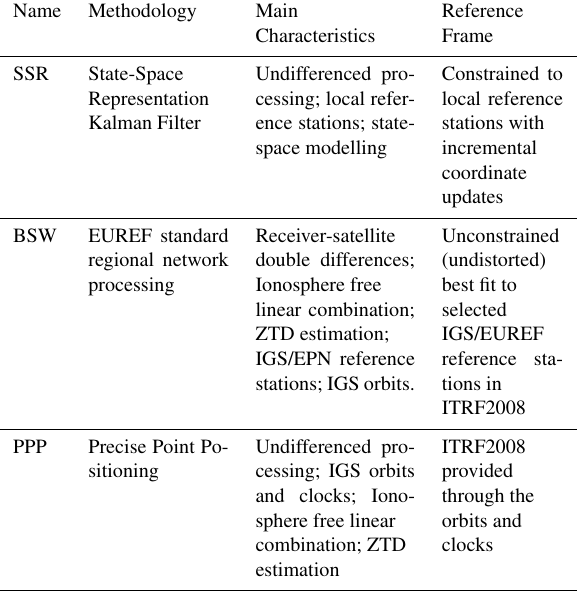
Table 2. GNSS processing methodologies. SSR processing has been carried out by 06-GPS using Geo ++ software (Wübbena et al., 2001); BSW by the Dutch Cadastre using the Bernese GNSS software (Dach et al., 2015); PPP by Nevada Geodetic Laboratory (NGL) using Gipsy/Oasis software (Blewitt et al., 2018).